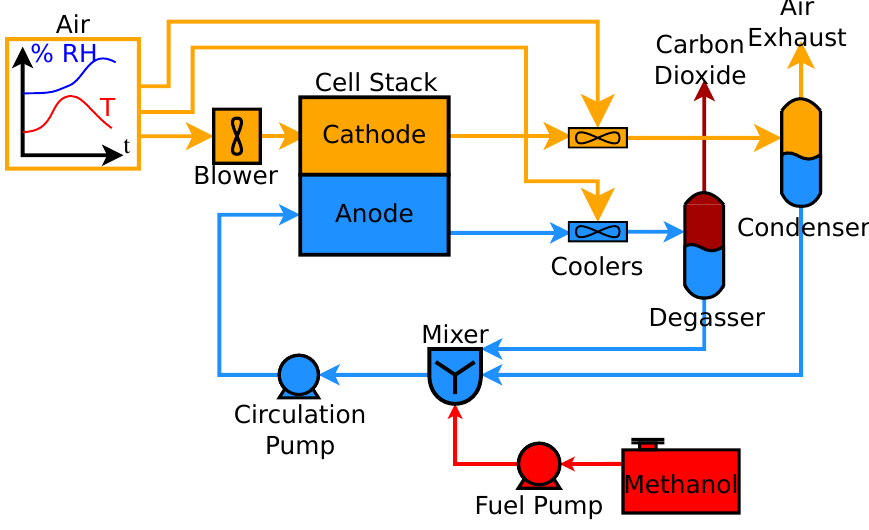
Figure 1. The process layout of the reference system [10].